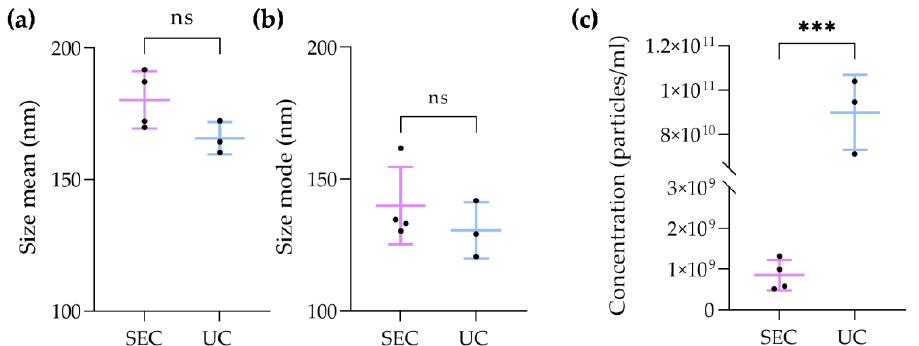
Figure 4. Comparison of EV diameter size and mode, and particle concentration between ultracentrifugation (UC) and size-exclusion chromatography (SEC): ( a ) graph showing the comparison diameter mean of EVs obtained with UC ( n = 3) and SEC ( n = 4) (unpaired t -test); ( b ) graph demonstrating the comparison of EV diameter mode of EVs isolated with UC ( n = 3) and SEC ( n = 4) (Mann–Whitney test); ( c ) graph presenting the difference between the concentration of particles isolated with UC ( n = 3) and SEC ( n = 4) (unpaired t -test). p value > 0.05 equals not significant (ns), and p ≤ 0.0001 ***.